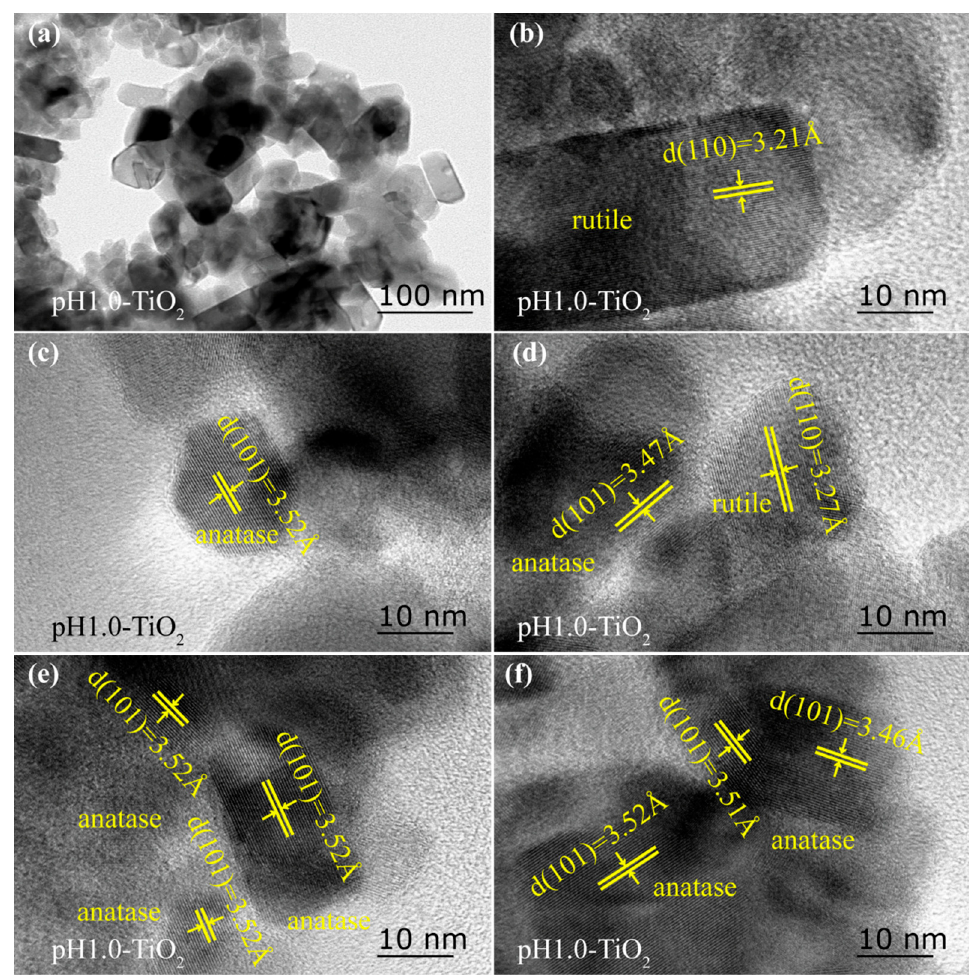
Figure 3. TEM ( a ) and HRTEM ( b – f ) images of the TiO 2 sample obtained at pH1.0 under hydrothermal conditions.